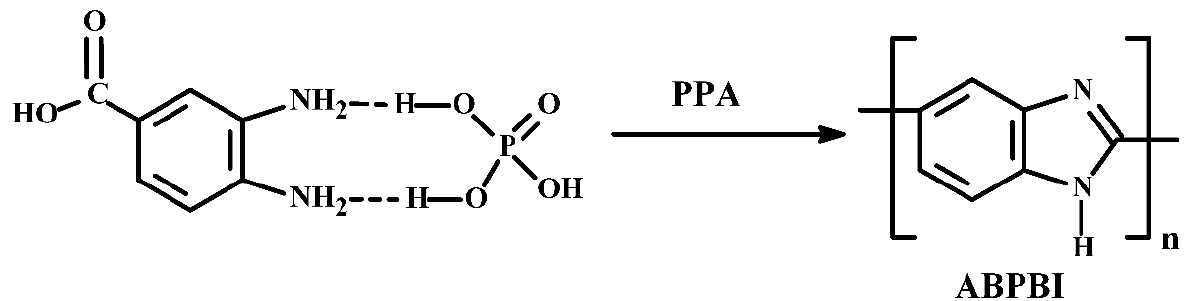
Figure A1. ABPBI synthesis scheme.